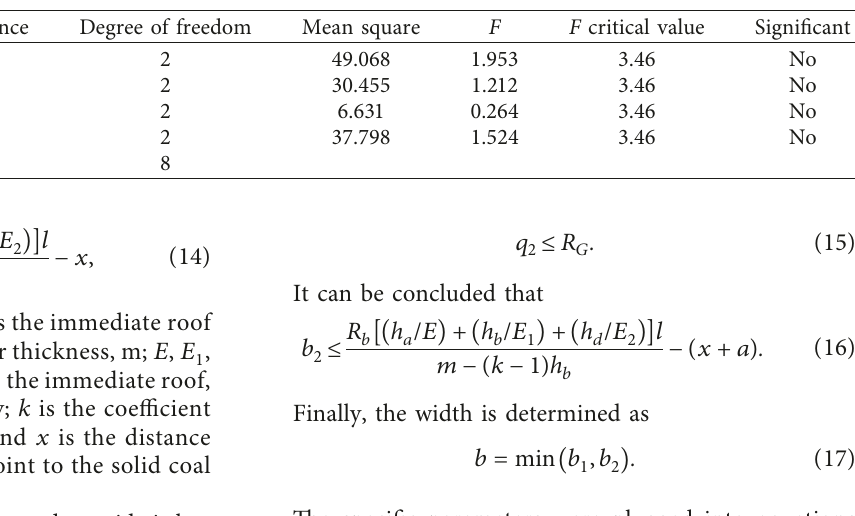
Figure 8: Test results of mechanical properties (compressive strength). Table 6: Analysis of variance